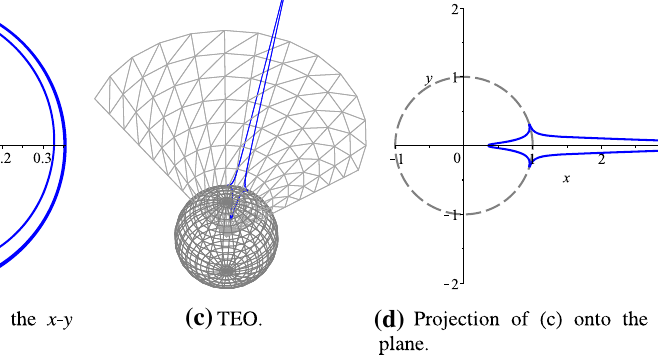
Fig. 11 TO and TEO for parameters K = 0 , L = 36 . 39992 , δ = − 1 , l = 0 . 3 , J = 4, and energy E = Ll = 10 . 919976. The trajectory lies on a cone with opening angle θ < π/ 2. The sphere and dashed